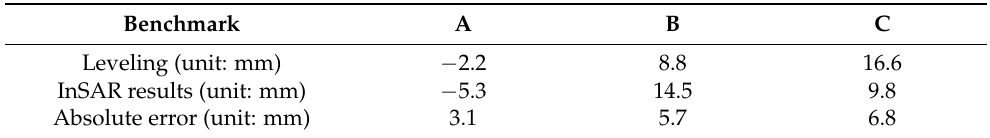
Figure 8. Geographic location map of leveling points along the QTR. Table 7. The absolute error between the measured values of leveling points A, B, and C and the InSAR observed